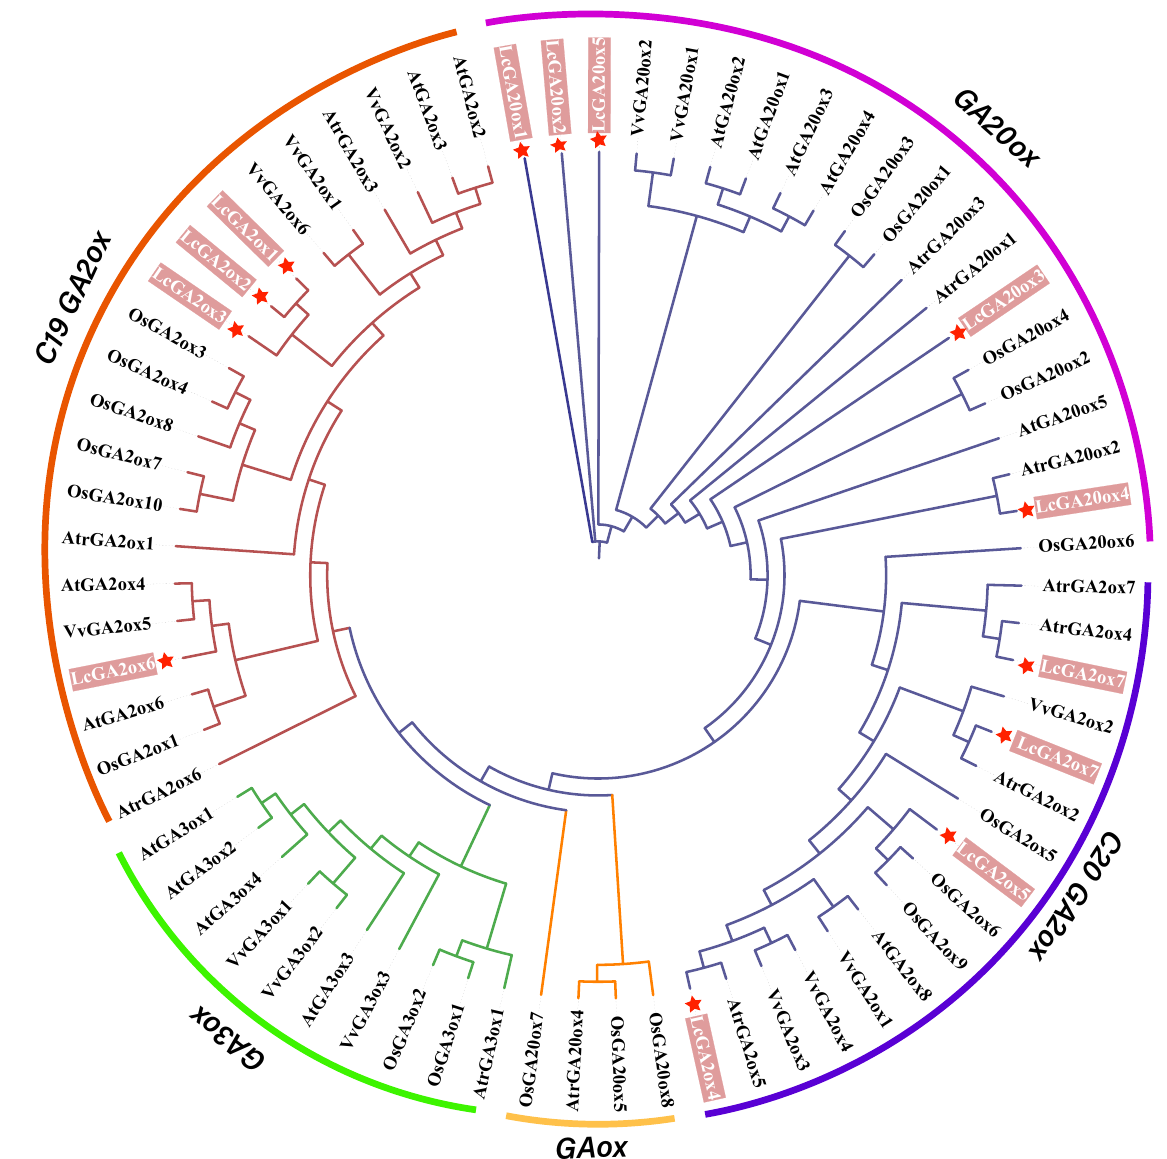
Figure 1. Phylogenetic analysis of gibberellin oxidase in L. chinense (Lc), O. sativa (Os), A. thaliana (At), A. trichopoda (Atr), and V. vinifera (Vv). The amino acid sequences of GA20ox , GA2ox , and GA3ox were aligned with ClustalX, and phylogenetic tree was constructed using maximum likelihood (ML) method in IQtree2.0.5 with 1000 bootstrap replicates, the LG + F + R6 was selected to the optimal model. The gibberellin oxidase genes in L. chinense were showed by star in